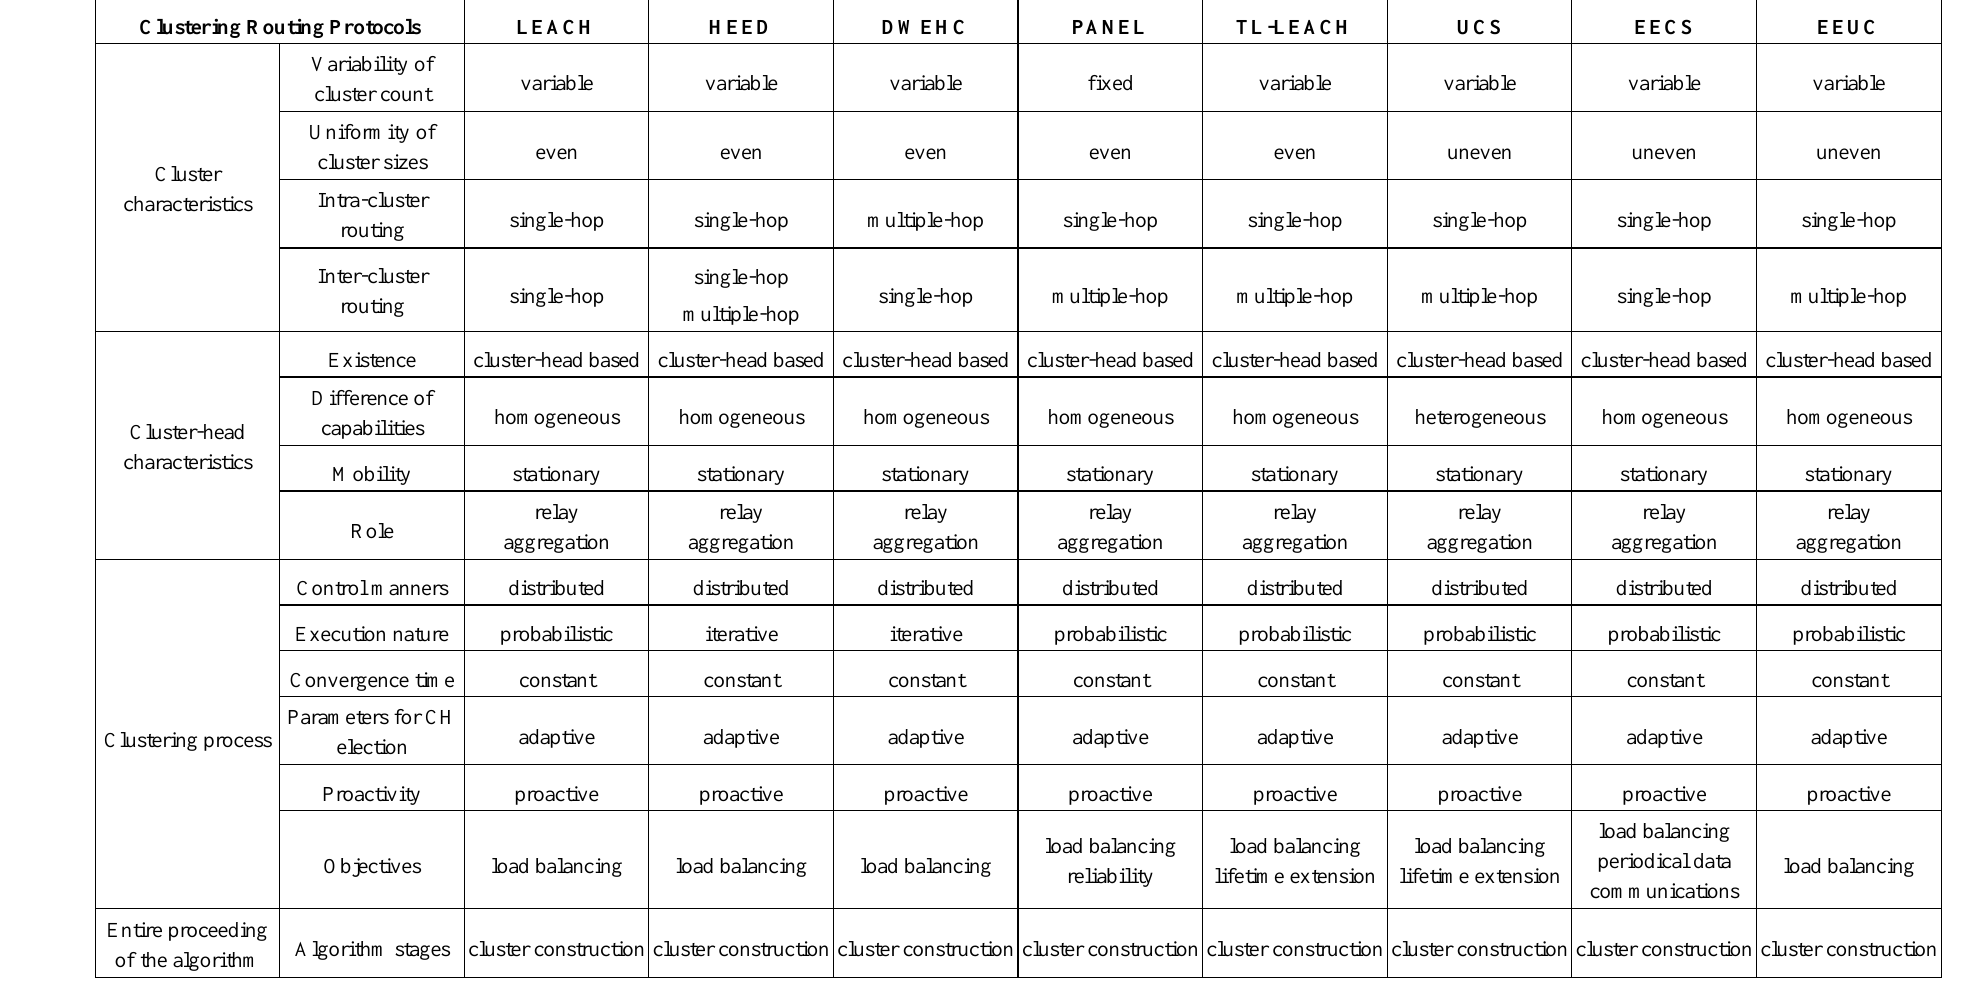
Table 2. Classification of Different Clustering Routing Protocols in